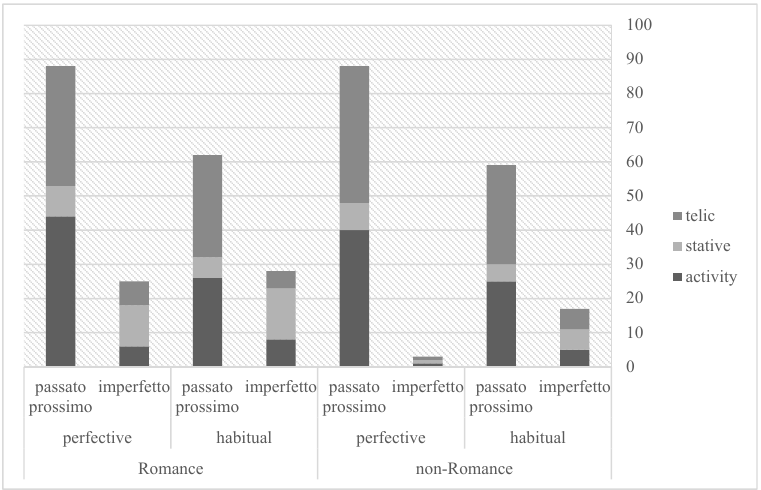
Figure 1. Number of occurrences of passato prossimo and imperfetto in perfective and habitual con- texts produced by low-proficiency learners according to lexical aspect (telic, stative, activity) and knowledge of a Romance language L2 (Romance, non-Romance).